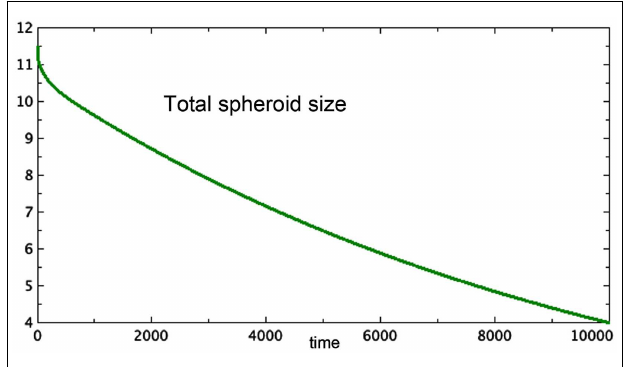
FIGURE 3 |Approximate terminal values at t = 10,000 for the run shown in Figure 2 are starting values in this run of Model 3E. Only total spheroid size is plotted.The growth rate of P was drastically decreased. a = 0.0001, b P,Q = 0.01, c Q,P = 0.005, d = 0.002, e Q,N = 0.002, f = 0.01, h = 0, m = 0.0001, P 0 = 0.426, Q 0 = 0.681, N 0 = 10 . 4.